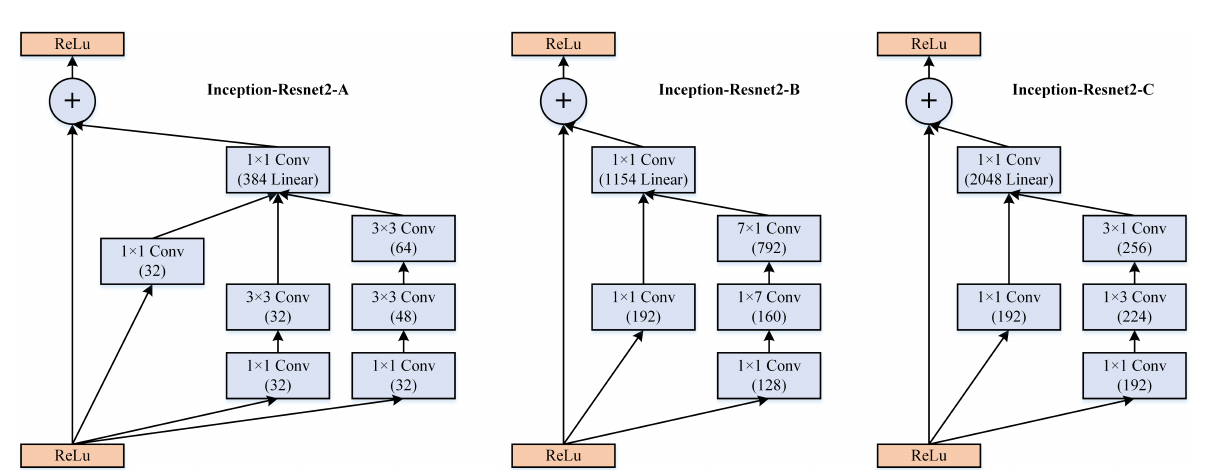
Figure 19. Inception-ResNet-V1.